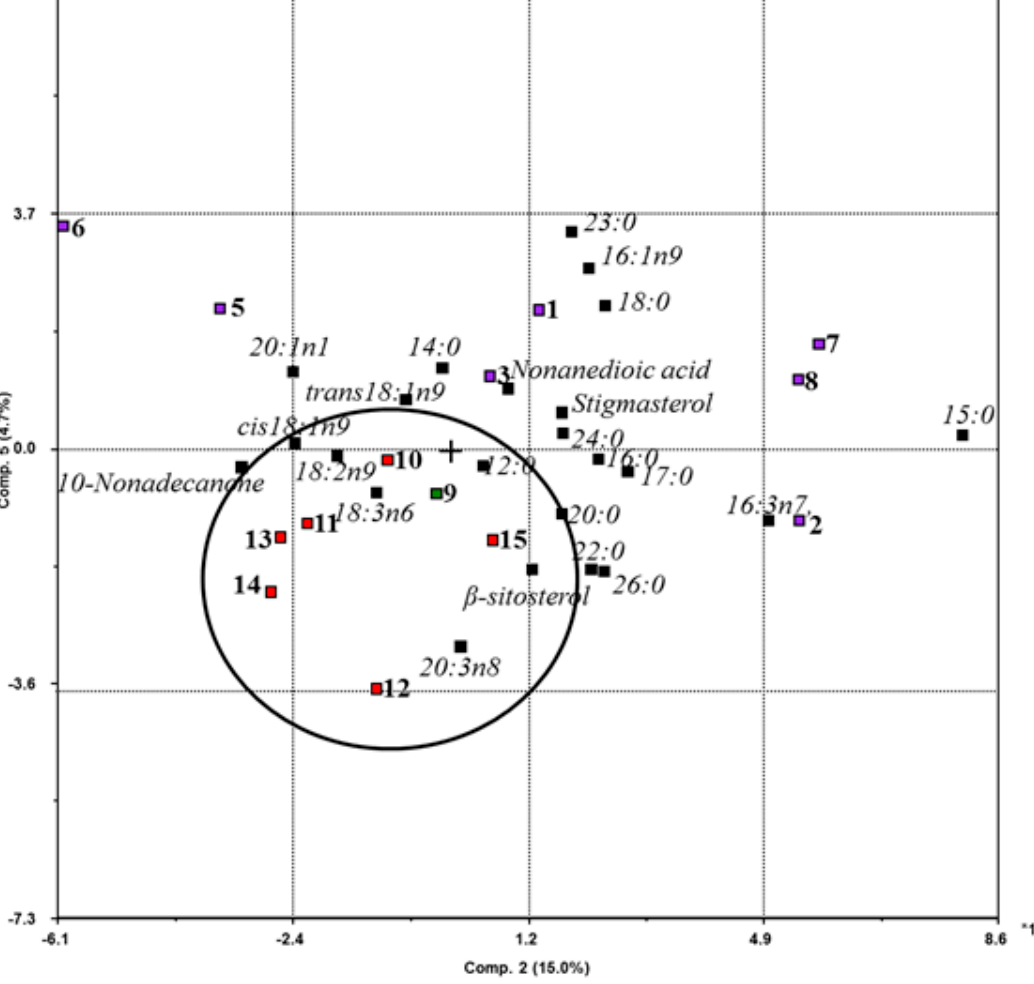
Figure 2. The principal component analysis biplot of the lipid fraction extracted from B. scorzonerifolium samples collected from different regions. Numerals indicate our data (Table 3). Violet-filled quadrants indicate samples from Buryatia (Russia), green-filled quadrants are samples from the Trans–Baikal region (Russia), red-filled quadrants are the samples from Khentii aimag (Mongolia). PCA of the lipid fraction of plants from different habitats showed that the samples from more biplot (Figure 2) and were characterized by a high level of unsaturated fatty acids. According to the